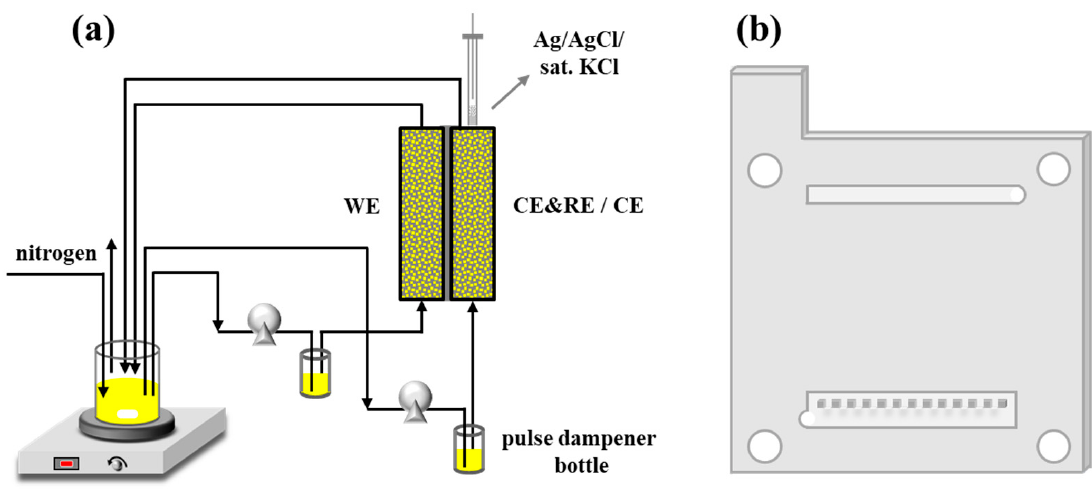
Figure 1. ( a ) Schematic of a symmetric cell setup; ( b ) Schematic of a titanium current collector with flow channels.